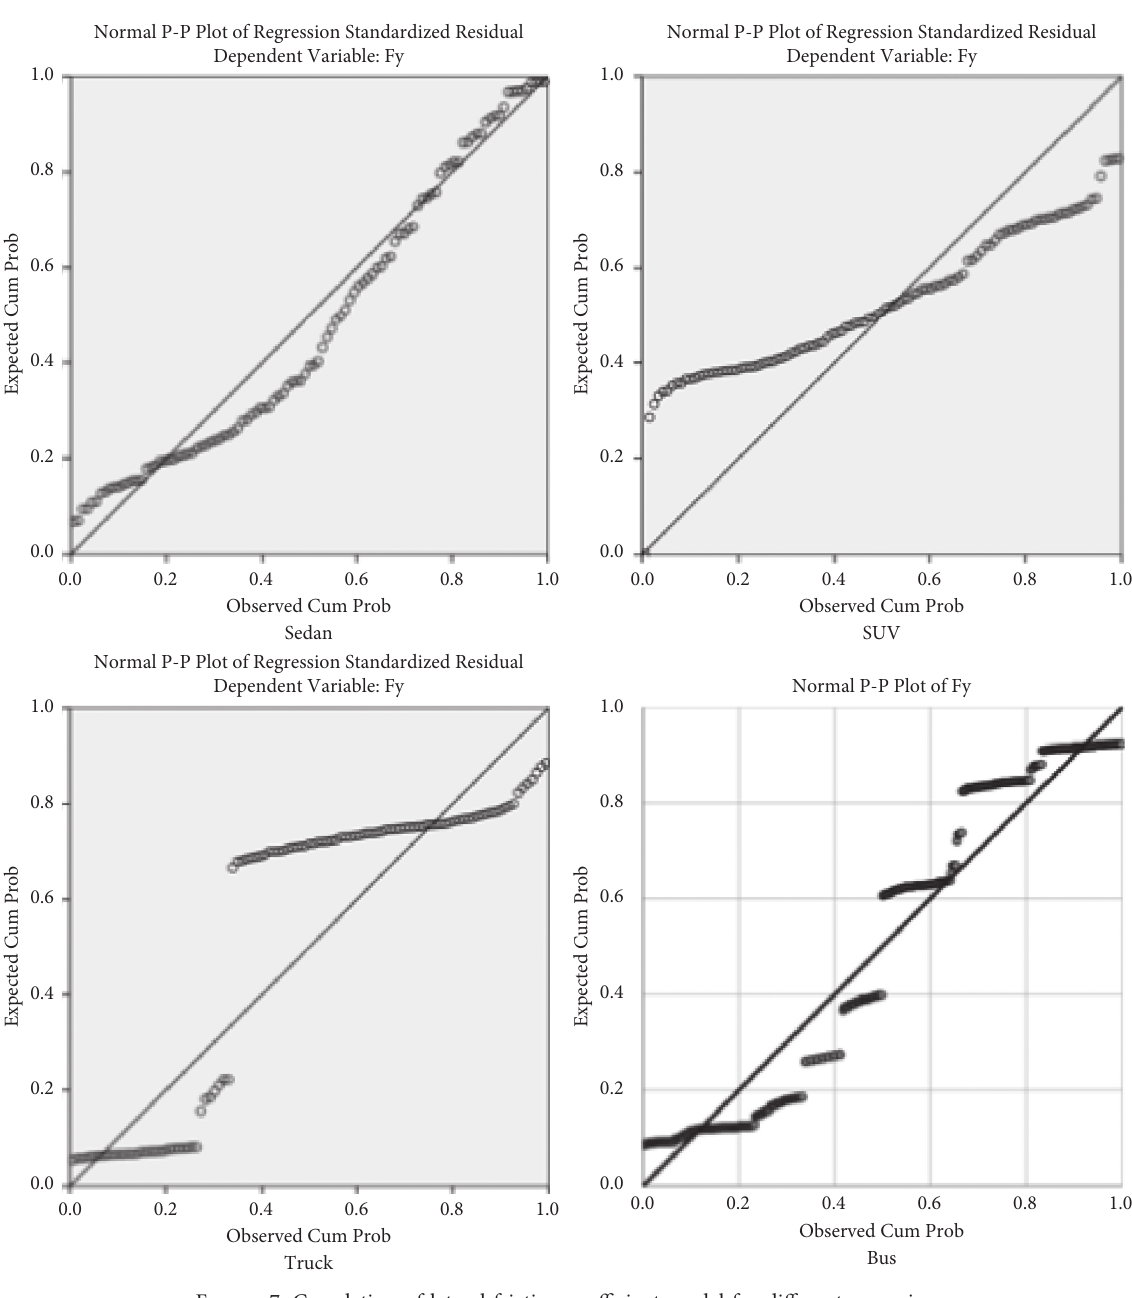
Figure 7: Correlation of lateral friction coefficient model for different